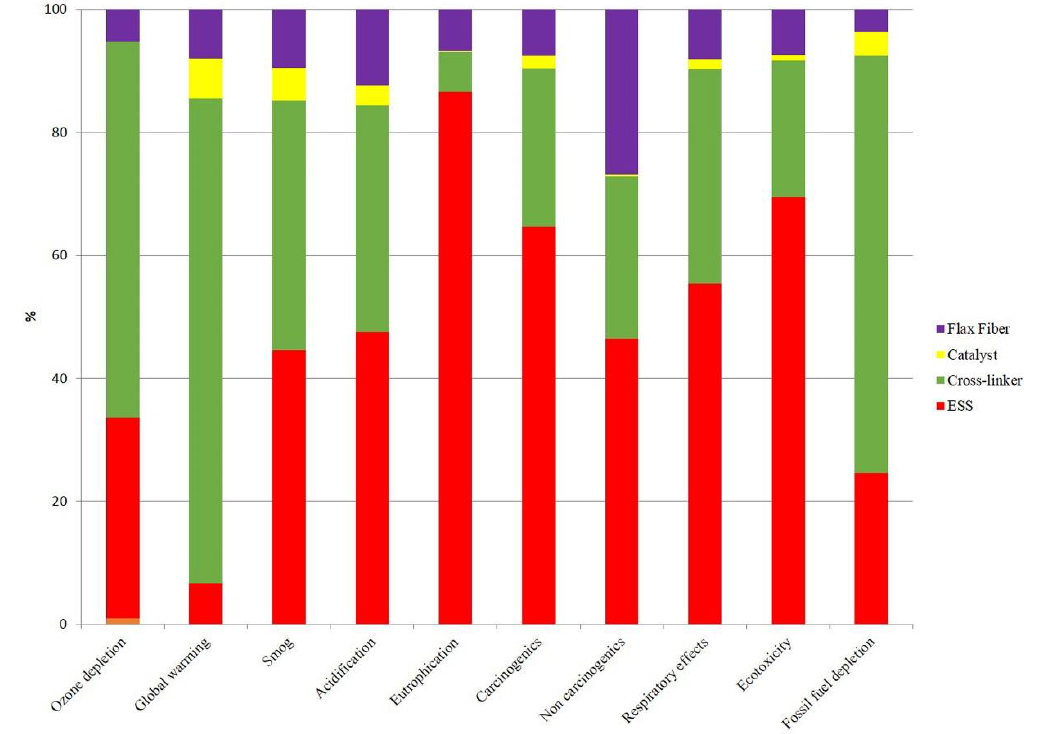
Figure 4. Contribution of biocomposite’s constituents to examined environmental impacts.